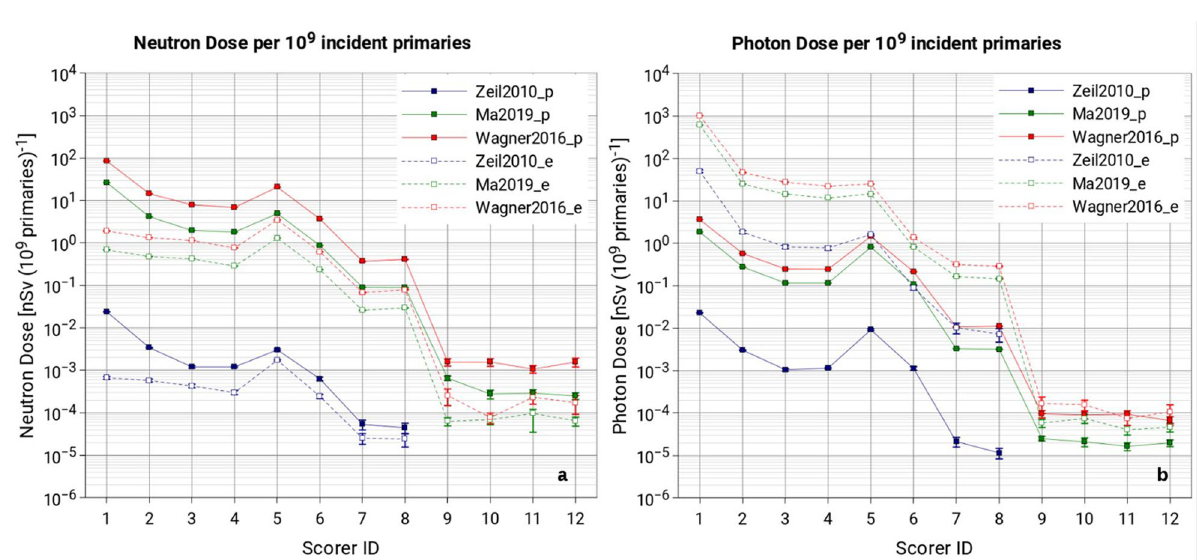
Figure 10. Neutron doses due to protons and electrons ( a ) and photon doses due to protons and electrons ( b ). Full markers represent the proton-induced component while open markers the electron-induced component. Data are expressed in terms of ambient dose equivalent and normalized to 10 9 incident primary particles. The uncertainty is depicted by vertical bars, where missing, it is because uncertainties are smaller than the marker itself. To better visualize the data, data points have been connected with straight